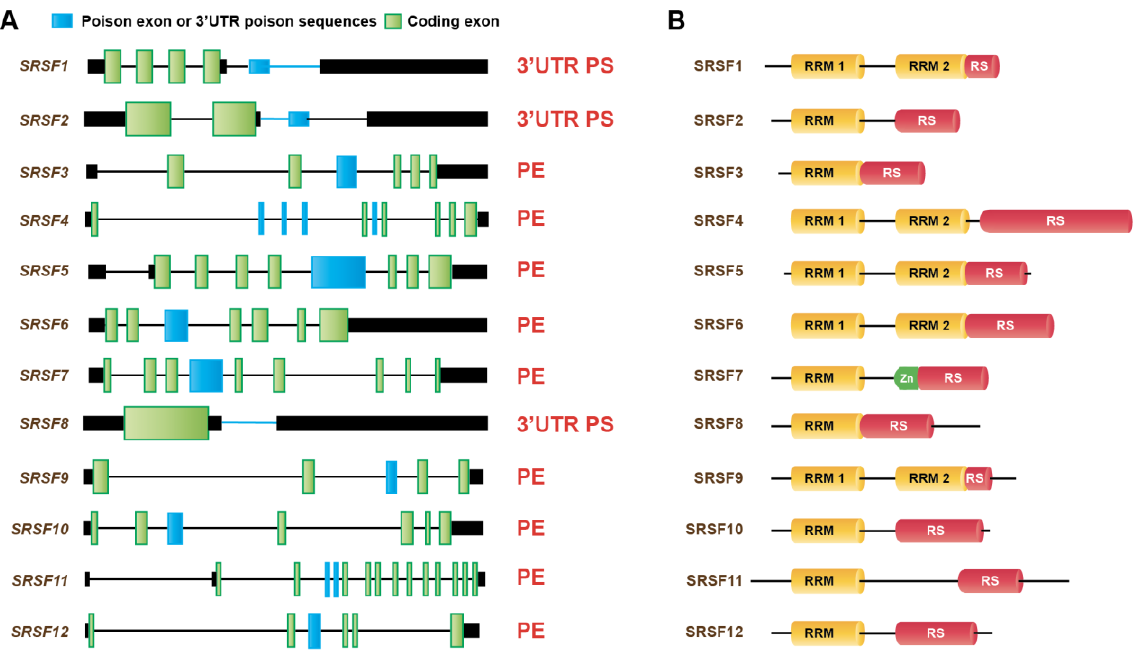
Figure 4. Gene and protein structures of SR protein splicing factors. ( A ) Schematics of SR protein genes with coding exons, non-coding regions, and internal poison exons or 3′UTR poison sequences (not to scale). The presence of poison exons or 3′UTR poison sequences in each gene is shown on the right. ( B ) Schematics of protein structure and domain organization of SR proteins (not to scale). PE: poison exons; PS: poison sequences; RRM: RNA recognition motif; RS: serine-arginine rich domain; Zn: zinc knuckle.